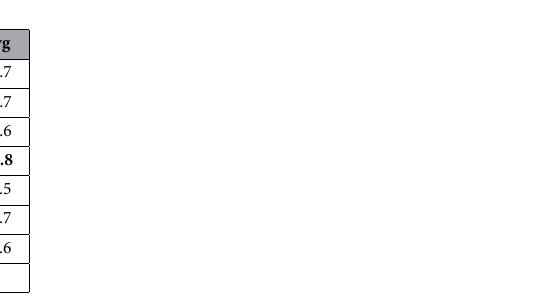
Table 9. Classification results for the masked spectrogram data domain, with patent features and different threshold values.